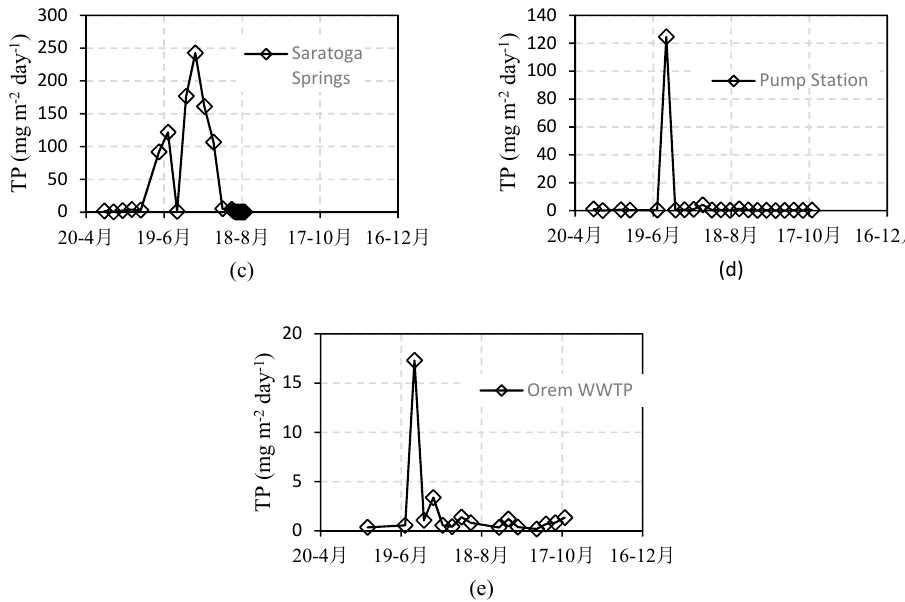
Figure 4. Temporal variations in TP by sample locations: ( a ) Lake Shore; ( b ) Mosida; ( c ) Saratoga Springs; ( d ) Pump Station; ( e ) Orem WWTP.